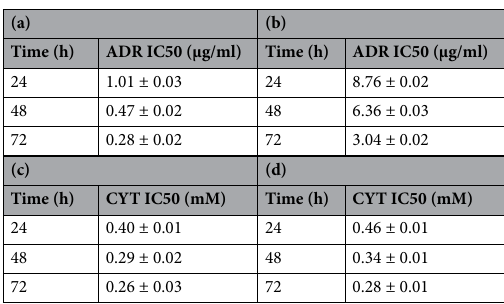
Table 1. The IC50 of MCF-7 and MCF-7/ADR at different times (mean ± SE). (a) IC 50 of ADR against the MCF-7 cells at 24, 48, and 72 h; (b) IC 50 of ADR against the MCF-7/ADR cells at 24, 48, and 72 h; (c) IC 50 of CYT against the MCF-7cells at 24, 48 and 72 h; (d) IC 50 of CYT against the MCF-7/ADR cells at 24, 48, and 72